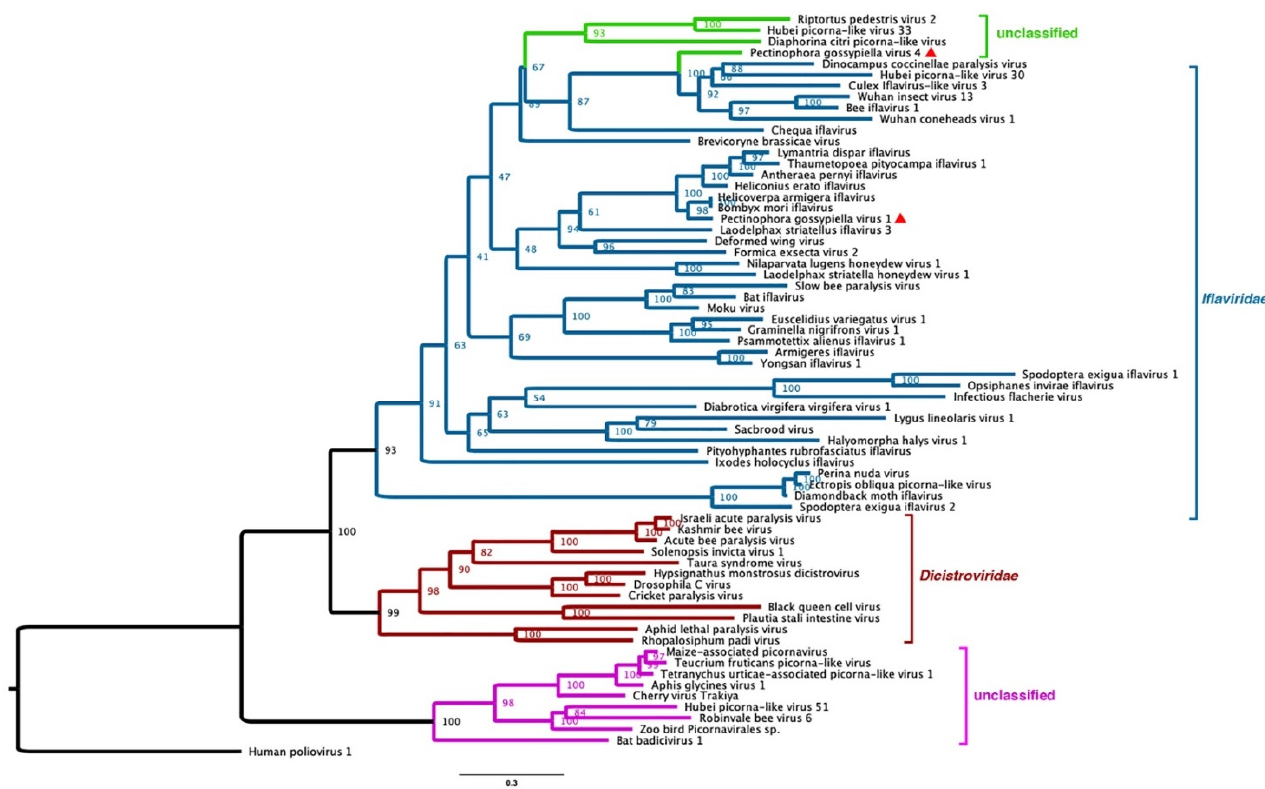
Figure 2. Phylogenetic tree of PecgV1 and PecgV4 (red triangle) with other iflaviruses. RdRP domain sequences (cd) were used. The accession numbers for sequences are listed in File S1. The amino acid sequences were aligned using ClastalW, and then the tree was constructed using Mega 7.0 with neighbor-joining method and evaluated with 1000 bootstrap replicates.